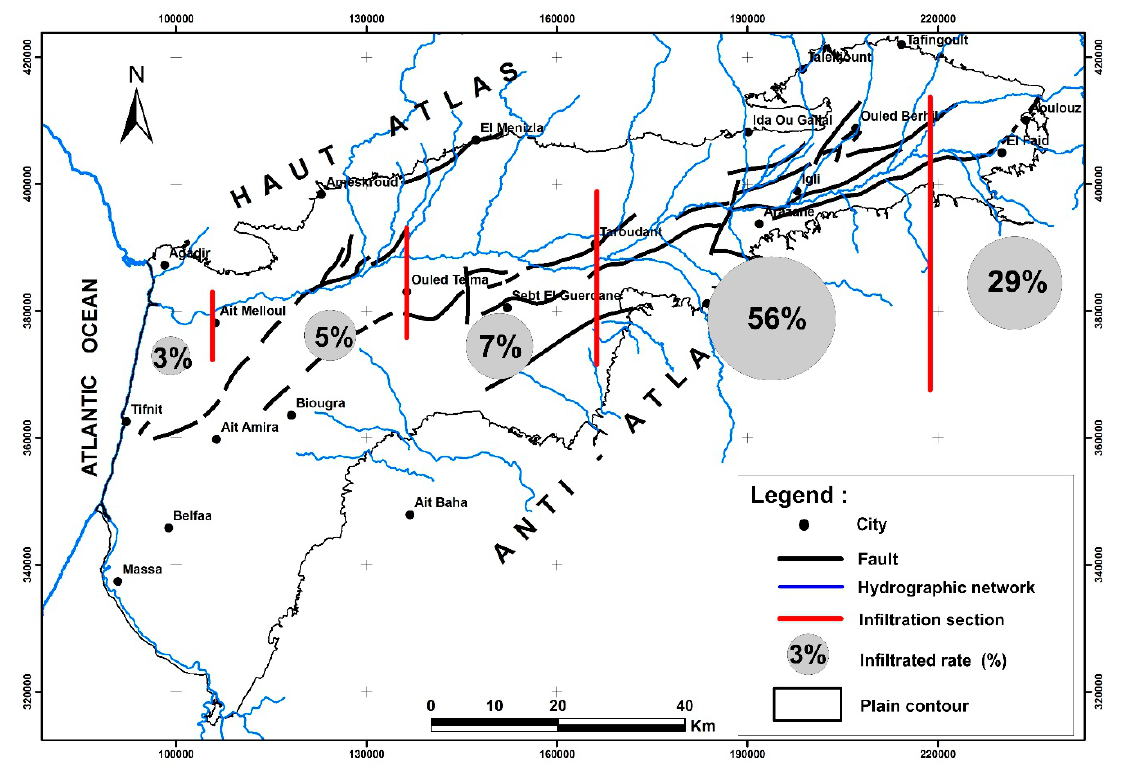
Figure 14. Infiltration rate in the Souss River bed after dam releases.